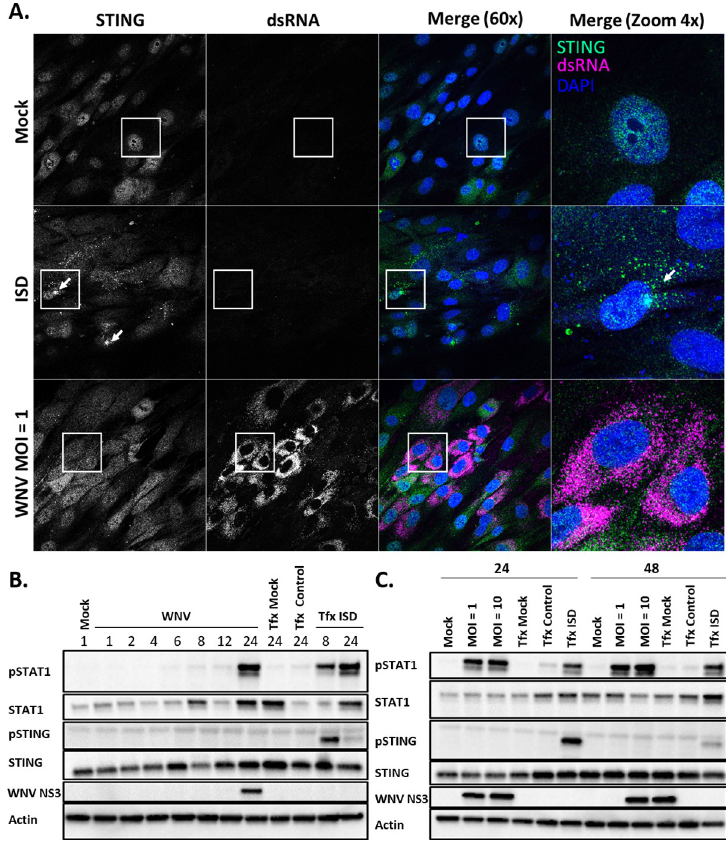
Fig 4. STING is not activated during WNV infection. (A) Immunofluorescence STING re-localization assay to assess STING activation. HFF cells were treated with PBS (Mock), transfected with ctDNA (ISD) for 3hr infected with WNV for 24h (MOI = 1). Cells were stained for endogenous STING and dsRNA. The data are representative for two independent experiments. (B-C) Western blot to detect activation of endogenous STING during WNV infection. (B) HFF were infected with WNV MOI = 1 and harvested at the indicated times post inoculation (hpi). (C) HFF cells were infected with WNV (MOI = 1, MOI = 10) and lysed at 24 and 48 hpi. In parallel, HFFs were transfected with ctDNA and harvested at the indicated times (B-C). The data are representative of three replicate